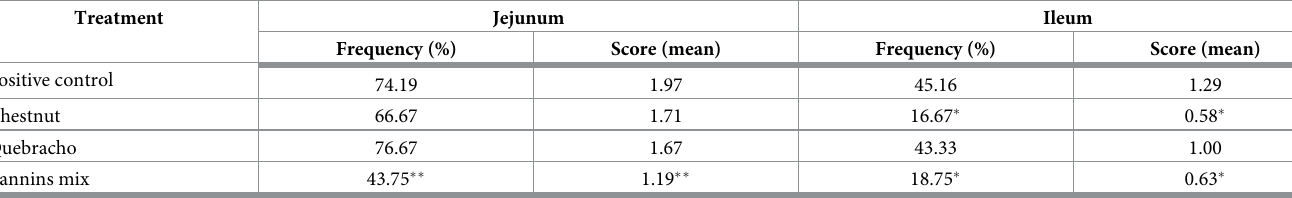
Table 9. Frequency and score of intestinal gross lesions1 (Experiment